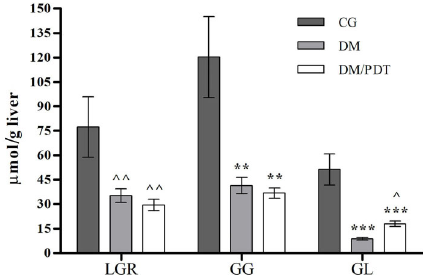
Figure 4. Liver glucose release (LGR), glycogenolysis (GG), and glycolysis (GL) rates during in situ perfusion of the liver of Wistar rats. CG: control animals without light irradiation; DM: type 1 diabetic animals without light irradiation; DM/PDT, diabetic animals with light irradiation. Data reported as means ± SD, n=5/